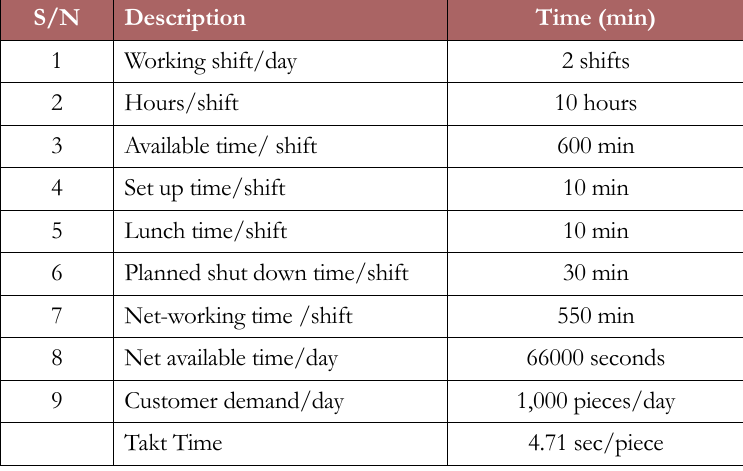
Table 8. Improved Takt time of AB Production